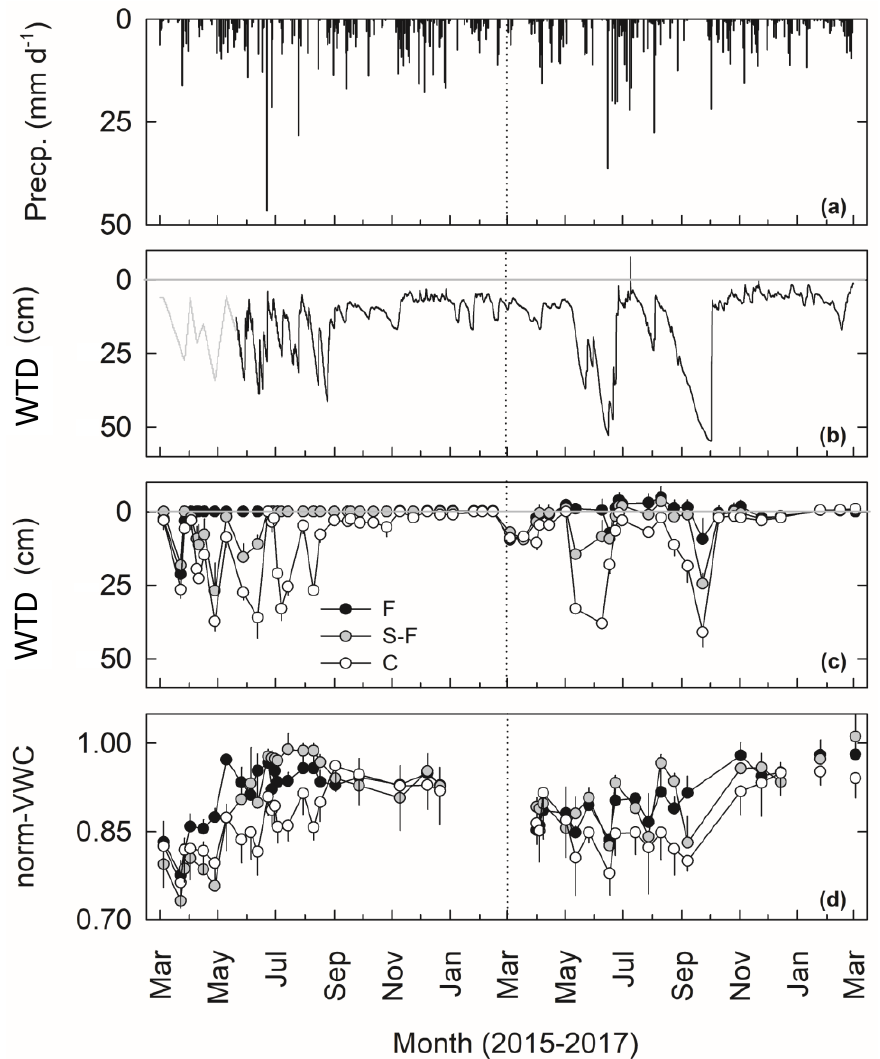
Figure 4. (a) Daily precipitation, (b) natural dynamics of water table depth below soil surface (WTD) in the study area, (c) dynamics of WTD in flooded (F), semi-flooded (S-F) and control (C) plots, and (d) volumetric water content (VWC) measured at 0–20 cm soil depth and normalised relative to the (collar- wise) maximum volumetric water content (norm-VWC). WTD (b) was at first measured manually at 1–2 week intervals (grey line) and then automatically at intervals of one hour (black line). Error bars in (c) and (d) represent the spatial variation (standard error, n = 4 for F plots and n = 2 for S-F and C plots). Unidirectional error bars are shown for clarity. The vertical dotted line separates the two study